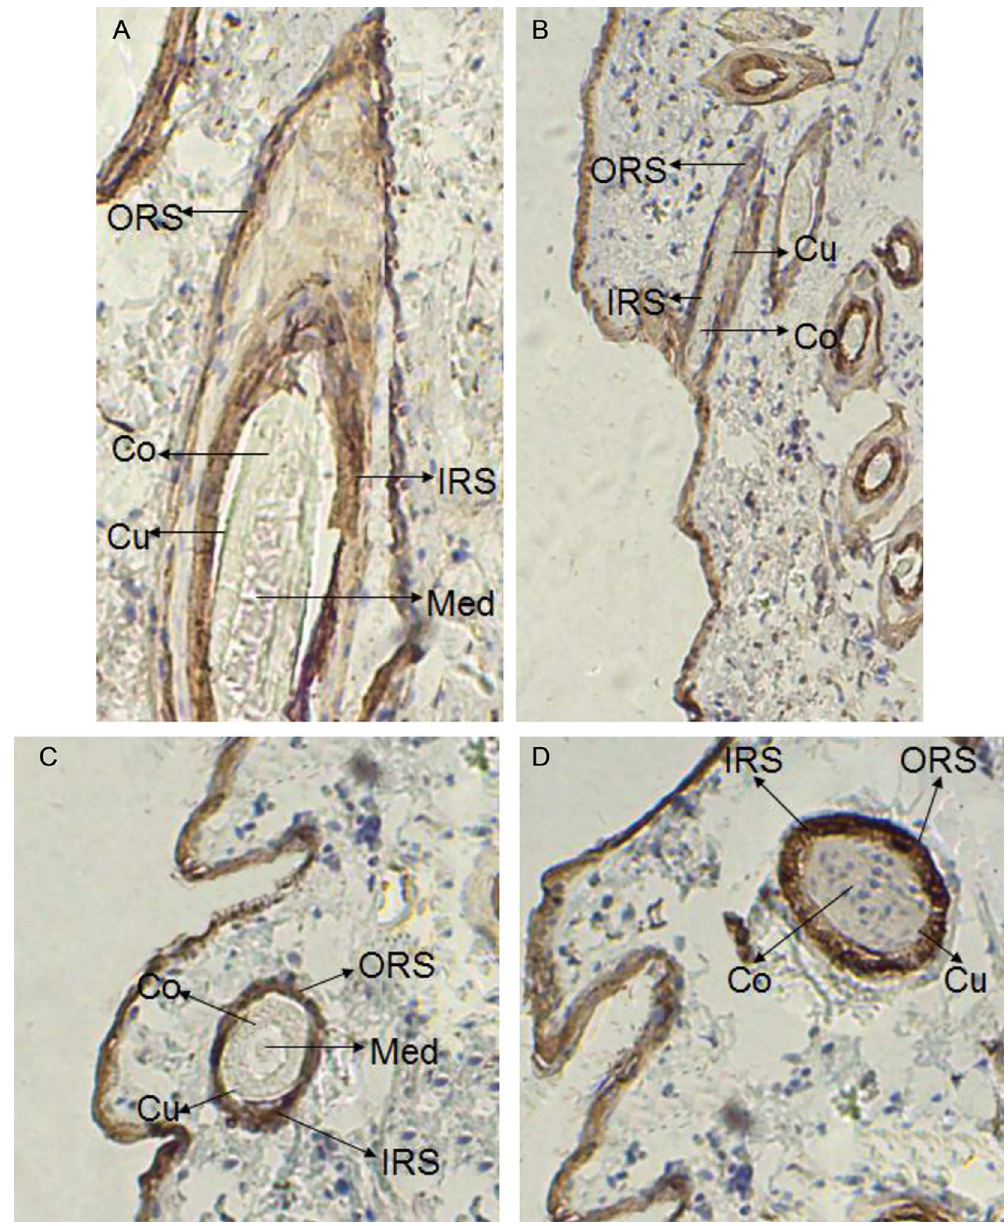
Fig 3. Expression of keratin 26 in skin was detected by immunohistochemistry in experimental group (100 × ). Fig 3A. Longisection of primary folliclein experimental group. Fig 3B. Longisection of secondary folliclein experimental group. Fig 3C. Transectionof primary follicle in experimental group. Fig 3D. Transectionof secondary follicle in experimental